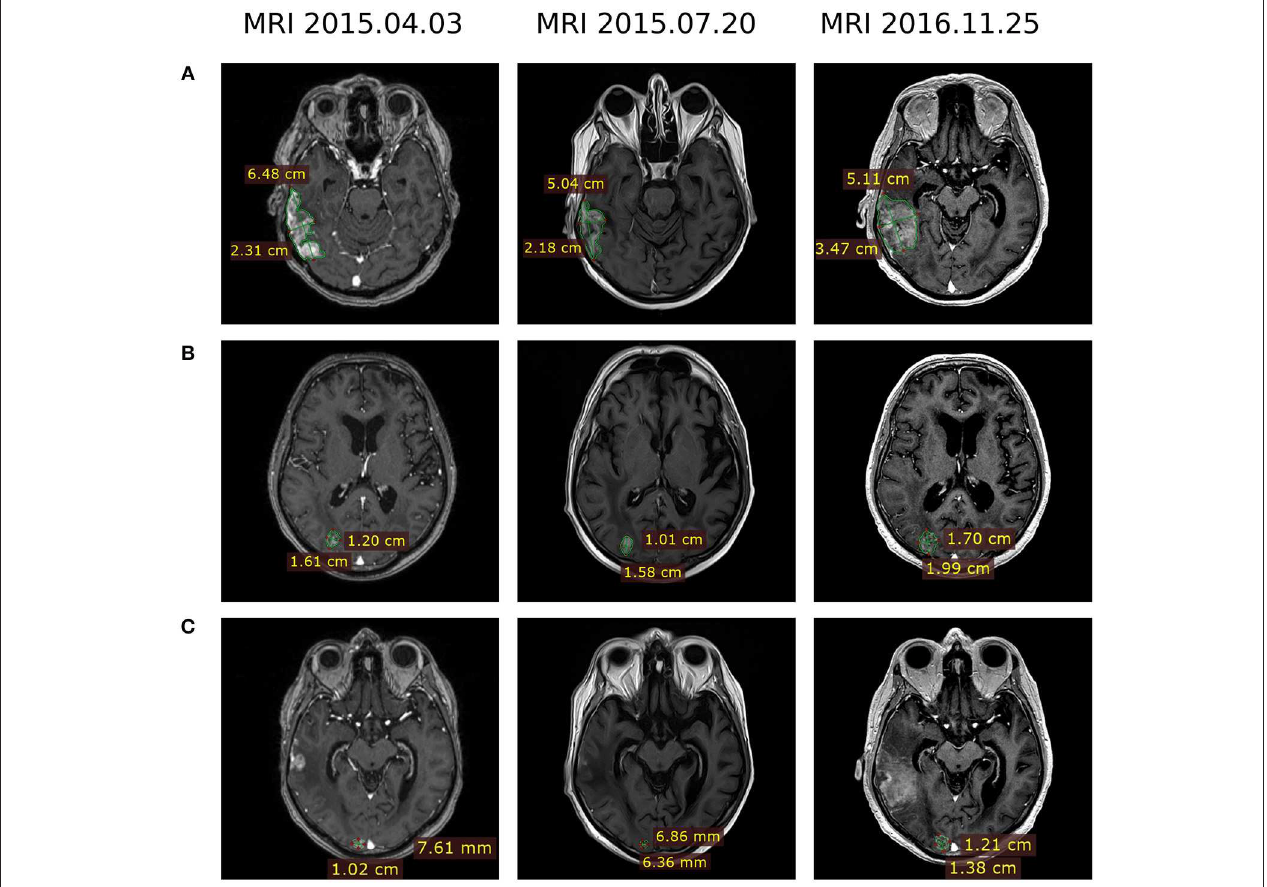
FIGURE 2 | MRI evaluation of brain metastases dynamics at therapy lines 3 and 4 after development of the ceritinib resistance. Treatment regimens were pemetrexed + cisplatin (2015.04.03), topotecan followed by crizotinib (2015.07.20) and crizotinib + bevacizumab (2016.11.25). (A) Lesion 1, right temporoparietal region. (B) Lesion 2, right occipital lobe. (C) Lesion 3, right occipital